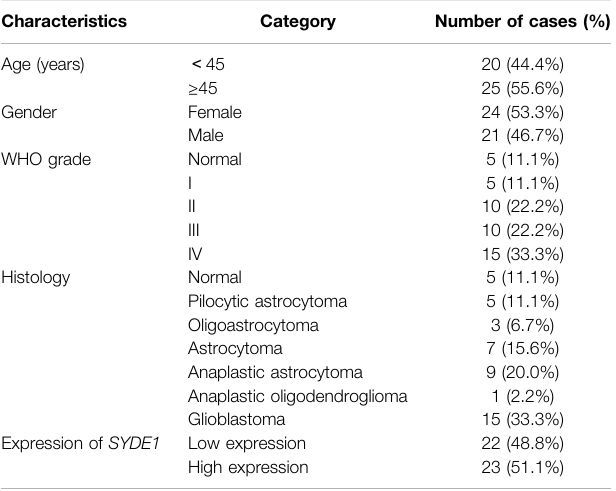
TABLE 1 | Clinicopathological characteristics of patient samples and expression of SYDE1 in glioma and normal tissues.